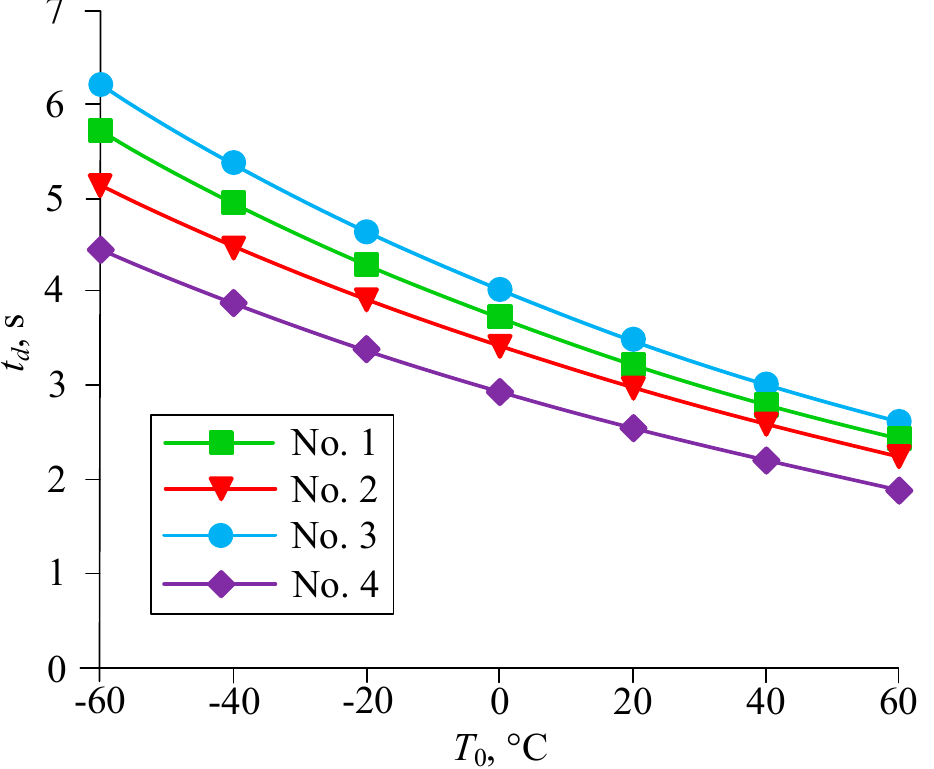
Figure 6. Dependences of the ignition delay times of composite liquid fuels on their initial tempera- tures ( T 0 ) at the heating source temperature of T g = 900 ◦